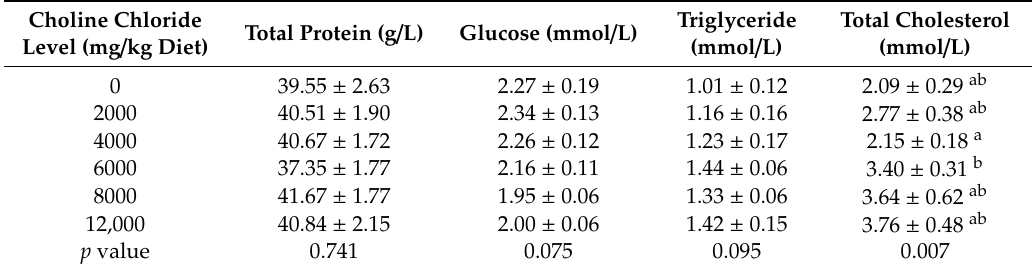
Table 4. E ff ects of di ff erent dietary choline chloride levels on the contents of total protein, glucose, triglyceride, and total cholesterol in the serum of L. vannamei (n = 4, mean ± SE).